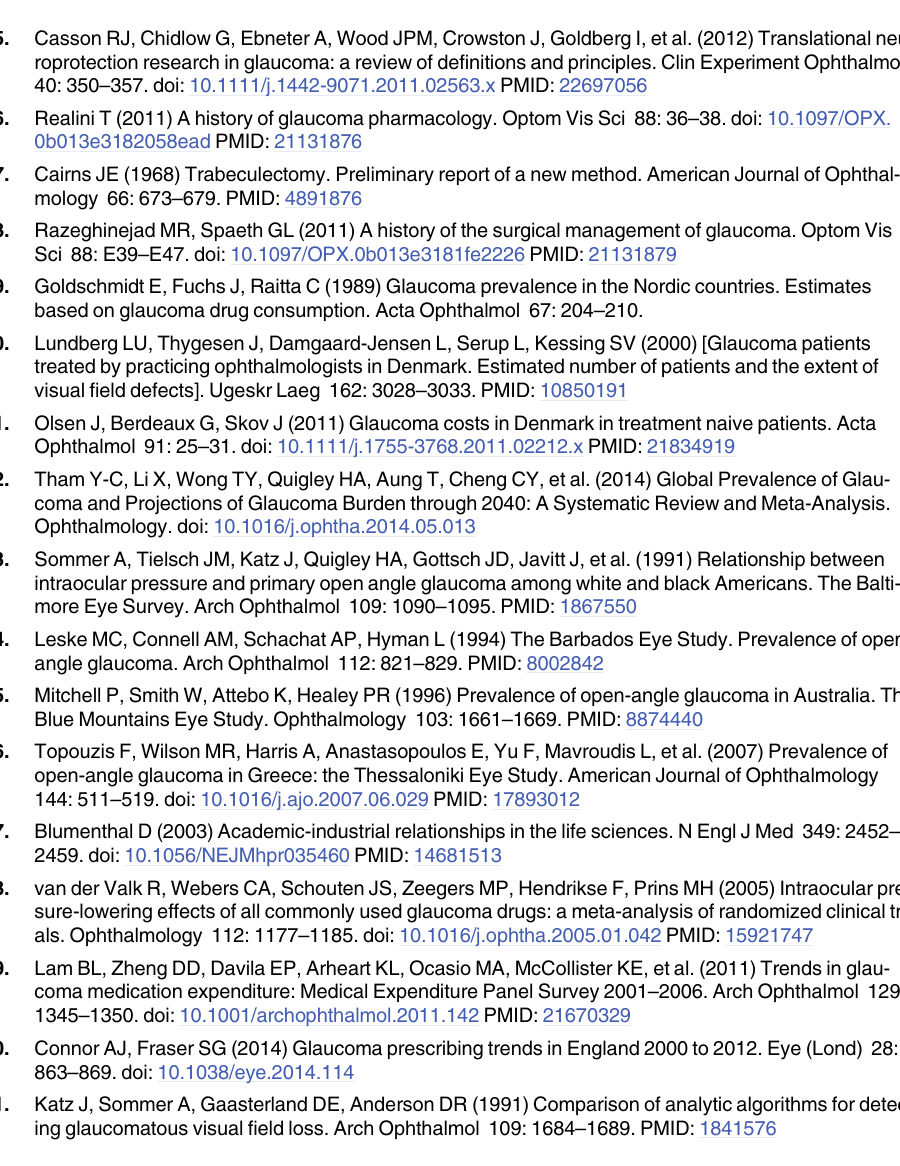
PLOS ONE | DOI:10.1371/journal.pone.0132048 July 16, 2015 11 /